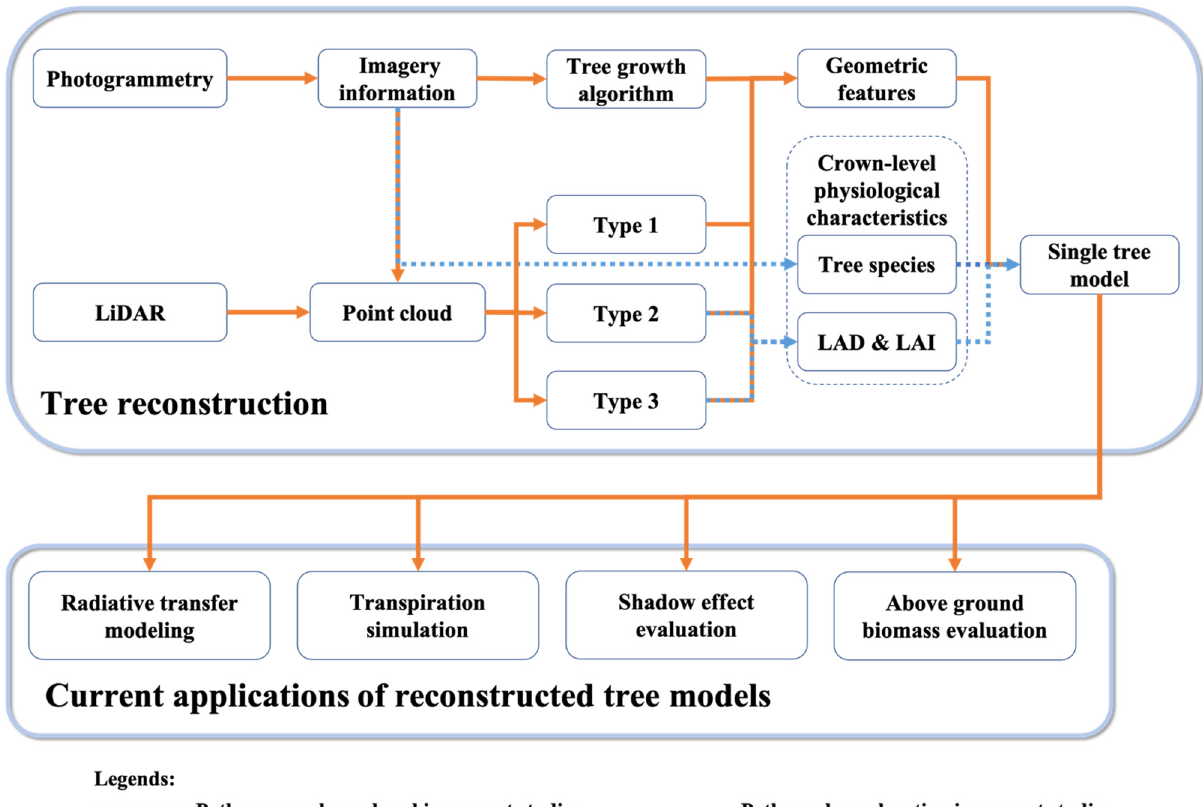
Figure 5. Current tree reconstruction approaches and applications of reconstructed tree models.